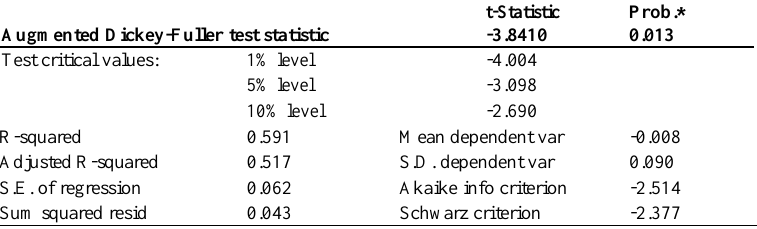
Table 6. Stationarity estimations of the first differences of the series ln (P) by the